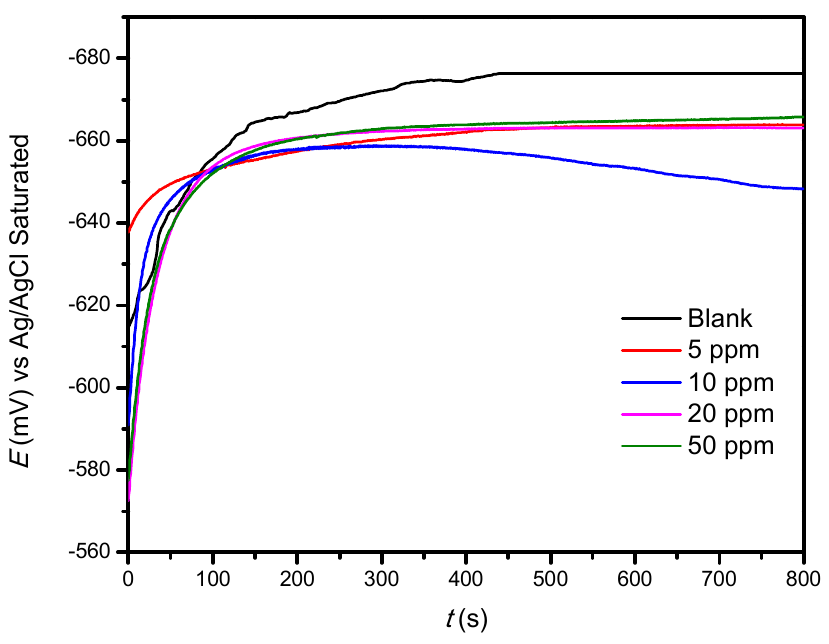
Figure 3. Potential variations at different concentrations of 4-PC as corrosion inhibitors in 1018 steel immersed in 3% NaCl + CO 2 .